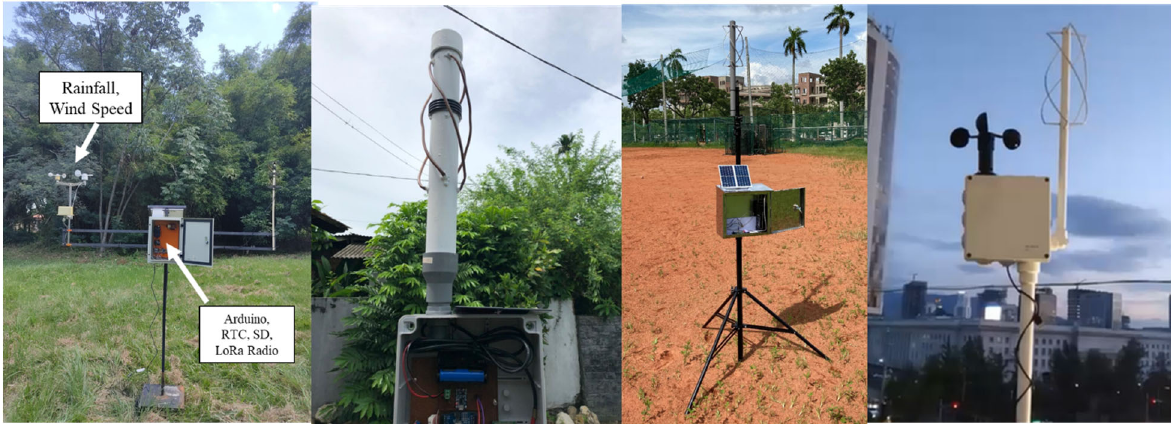
Figure 13. The GSTs developed in various countries as Paraguay, Malaysia, Taiwan, and Mongolia from left to right.